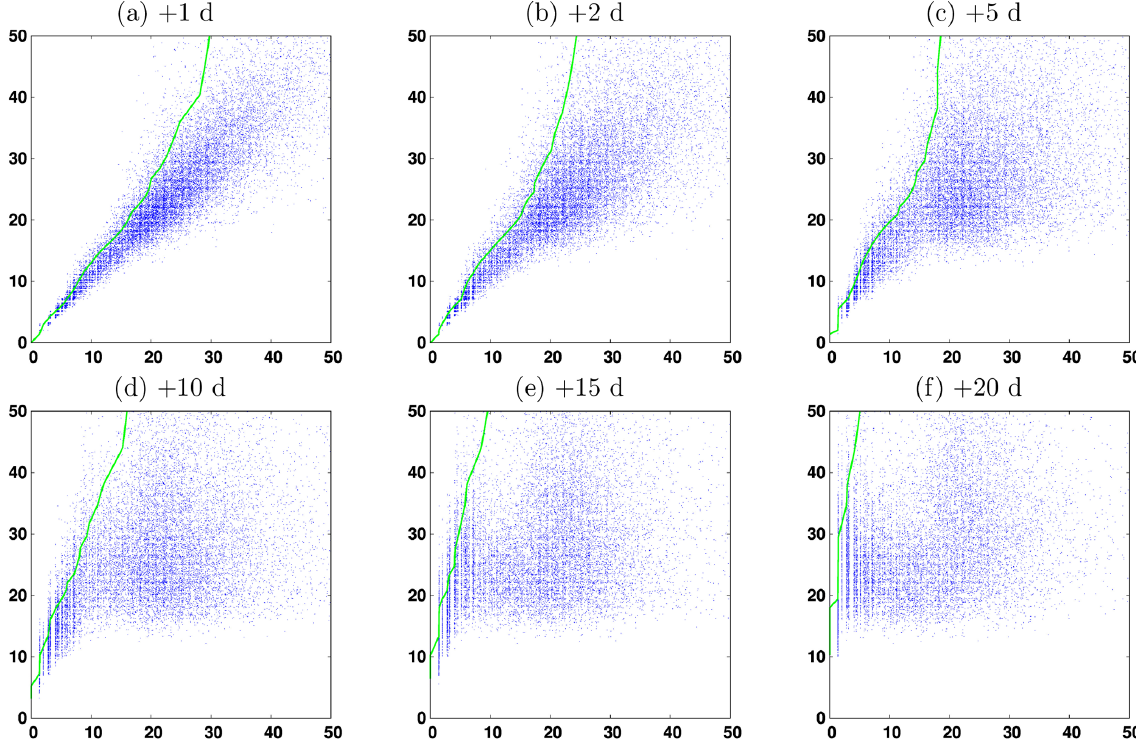
Figure 15. Final SST location score ( y axis, in km) as a function of the initial SST location score ( x axis, in km) for experiment ENS-CI for six time lags (cid:49)t = 1, 2, 5, 10, 15 and 20d (from a – f ). The green line corresponds to the initial score required to have a 95% probability that the final score is below a given value.